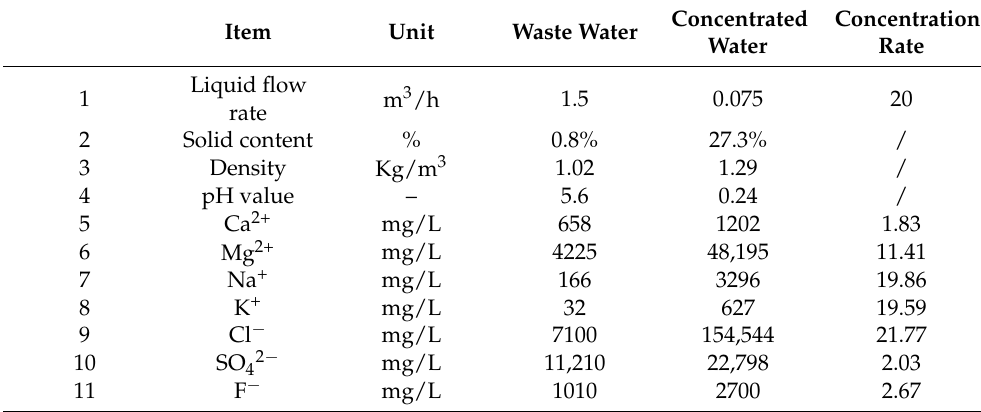
Table 2. Ion analysis of the WFGD wastewater of the concentrating